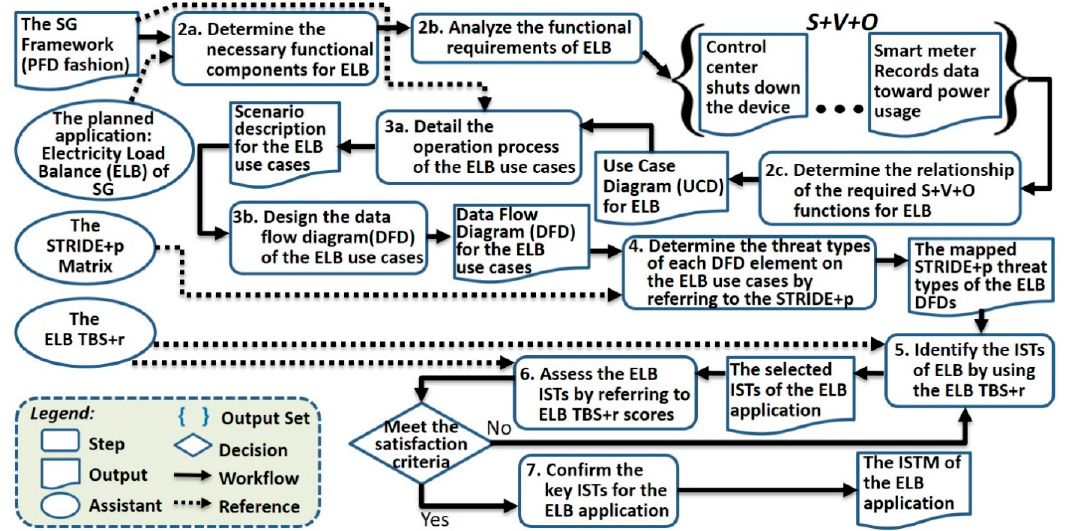
Figure 8. The ISTM process for the ELB practice.